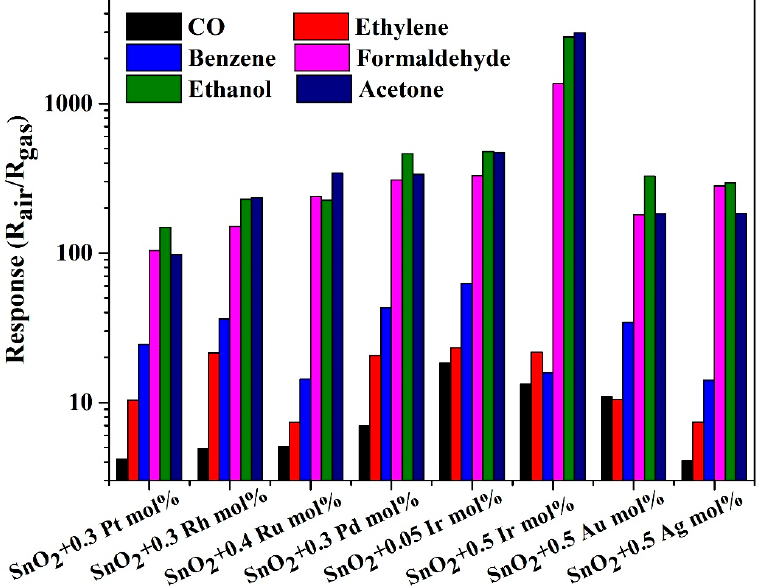
Figure 7. The selectivity of the eight selected materials to 100 ppm of the tested gases.